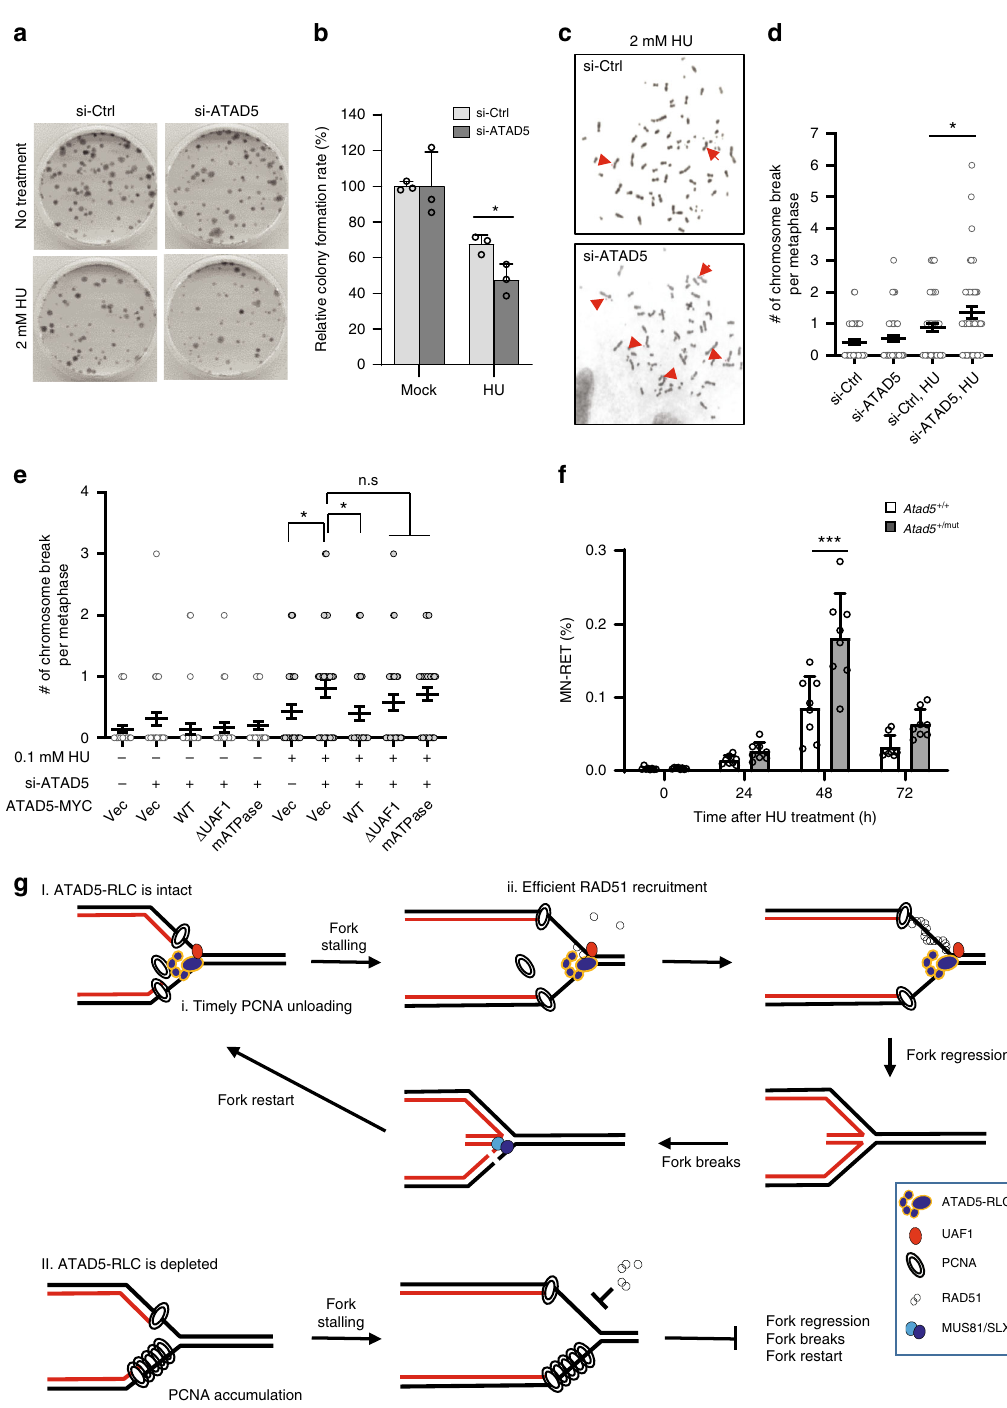
Fig. 6 ATAD5 depletion increases cell death and genomic instability in cells and mice. a , b U2OS cells transfected with ATAD5 siRNA under the Noco- APH condition were treated with 2 mM HU for 6 h, plated in the absence of drug treatments, incubated for 2 weeks, and examined to detect surviving colonies by methylene blue staining. a Representative images of colony staining. b The viability of the surviving colonies was quanti fi ed. Error bars represent standard deviation of the mean ( n = 3). Statistical analysis: two-tailed Student ’ s t test; * p < 0.05. c , d U2OS cells transfected with ATAD5 siRNA under the Noco-APH condition were treated with HU for 6 h and subjected to metaphase spreading. c Representative images of DAPI stained chromosomes are shown. Arrows point to chromosomal breaks. d The number of chromosomal breaks per cell was plotted. Statistical analysis: two-tailed Student ’ s t test; * p < 0.05. e U2OS-TetOn-ATAD5 cell lines expressing wild-type or two ATAD5 mutants were treated with doxycycline and transfected with ATAD5 siRNA under the Noco-APH condition. Cells were then treated with HU for 6 h and subjected to metaphase spreading. Statistical analysis: two- tailed Student ’ s t test; * p < 0.05. n.s., not signi fi cant. f Atad5 wild-type or mutant mice were analyzed by micronucleus analysis. Error bars represent standard deviation of the mean ( n = 8). Statistical analysis: two-way analysis of variance, *** p < 0.001. g The model described in the